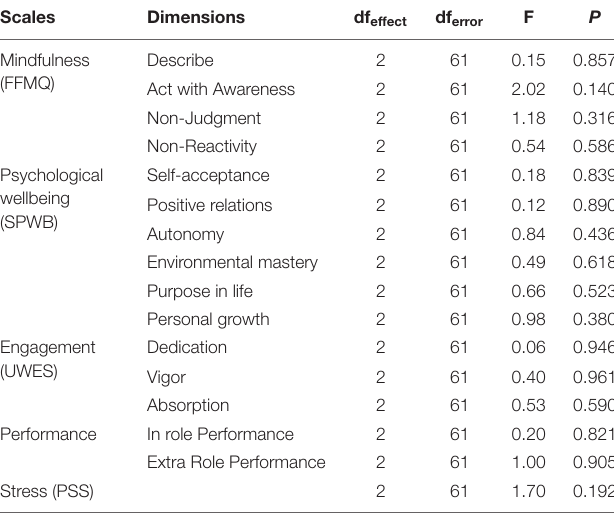
TABLE 5 | Pre-intervention one-way ANOVA test with group as comparison factor.